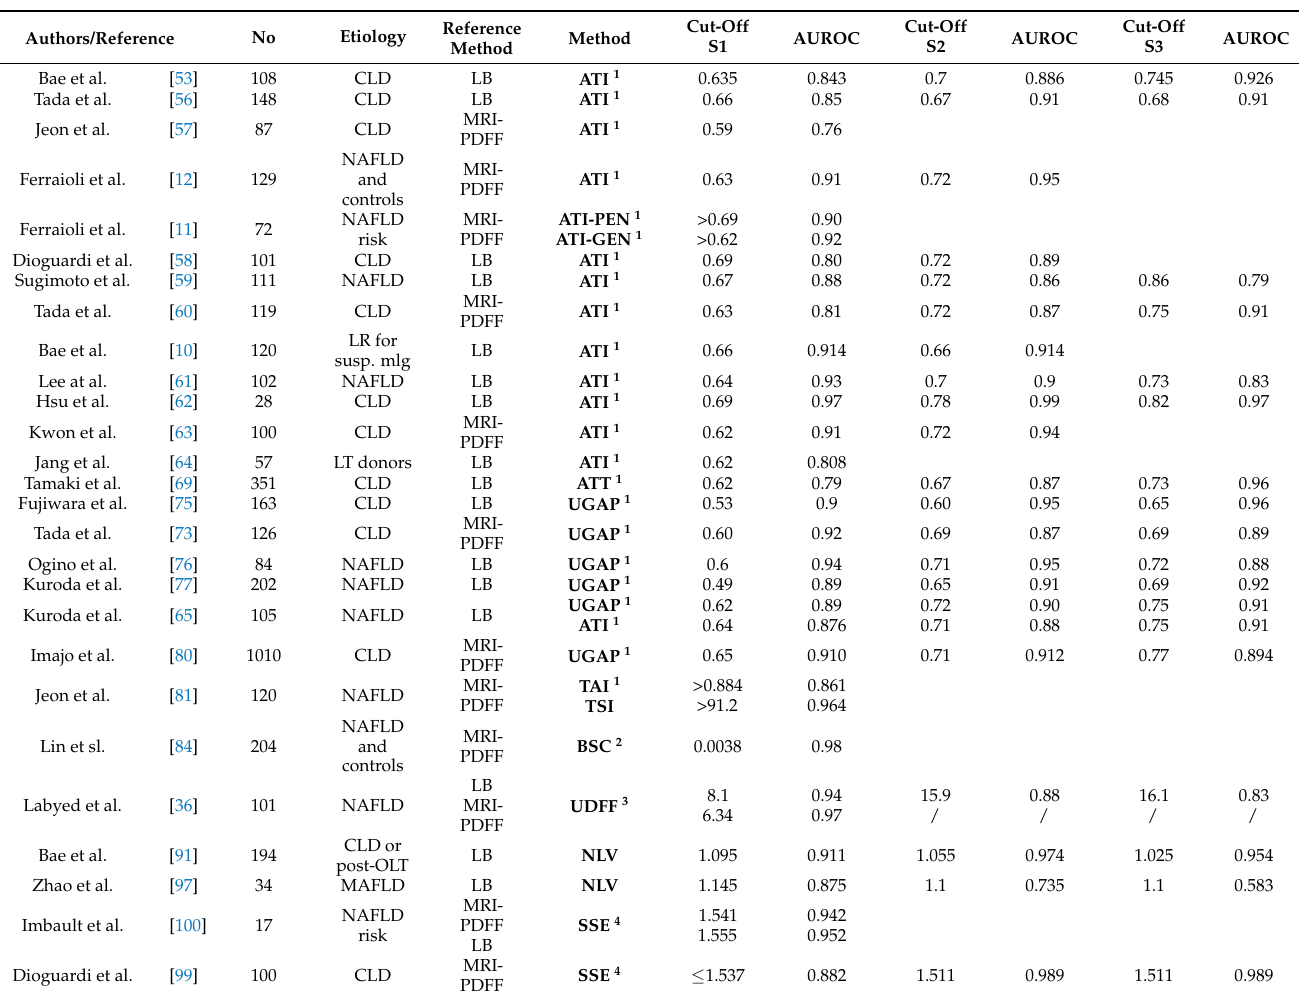
Table 4. Studies assessing the accuracy of ultrasound-based methods in the quantification of LS compared to the reference methods (LB and MRI-PDFF) in adults